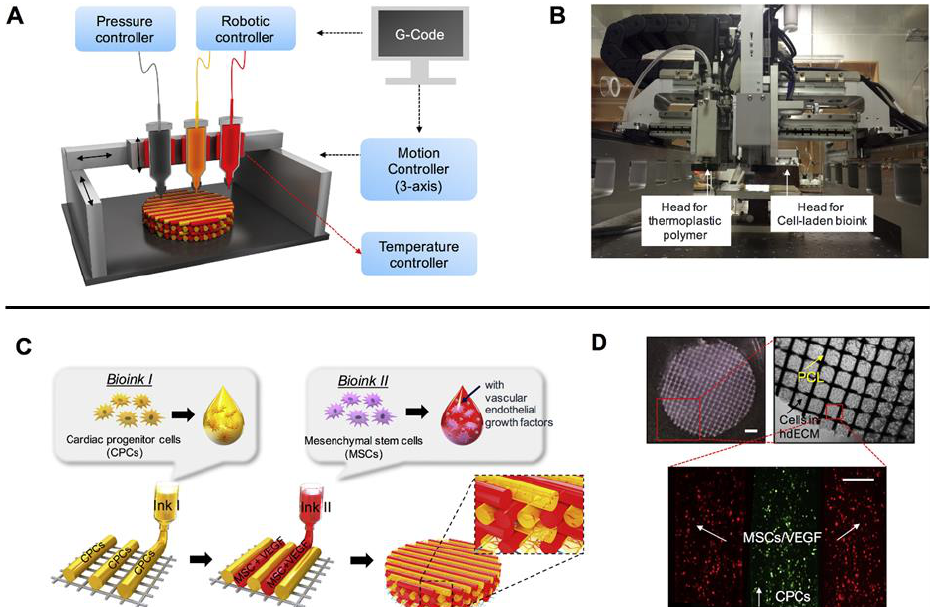
Figure 1. 3D printed patch for cardiac fibrosis treatment, with user-defined spatial patterning of cardiac progenitor cells and mesenchymal stem cells. ( A ) Schematic of extrusion-based 3D printing system. ( B ) Photograph of extrusion printer. ( C ) Patterning of distinct bioink formulations and cell types within each layer. ( D ) 3D printed patch, including zoom-ins of layer-based geometry and distribution of cell types within printed fibers. Top-left scale bar represents 1 mm, while bottom scale bar represents 200 μm. Adapted with permission from [27], 2017, Jang et al.